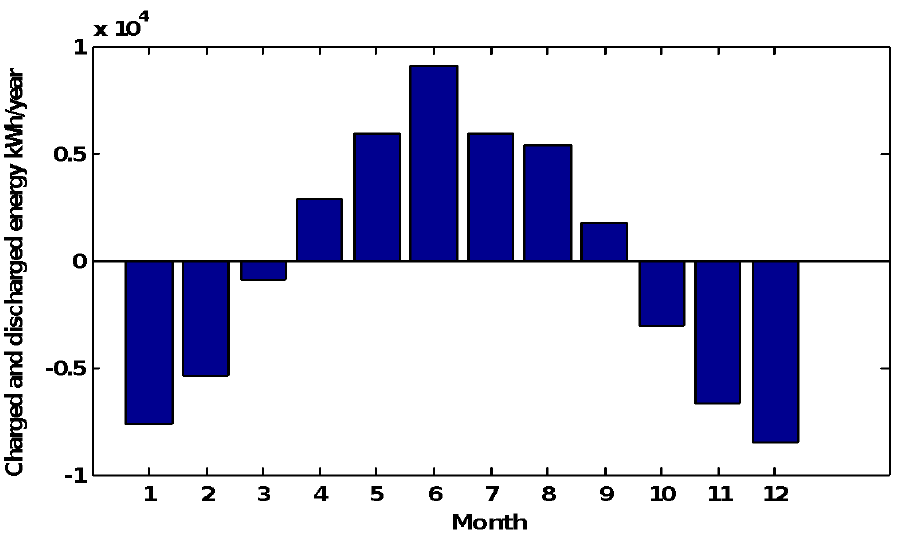
Figure 10. Surplus energy lost in batteries with 6884 kg emissions